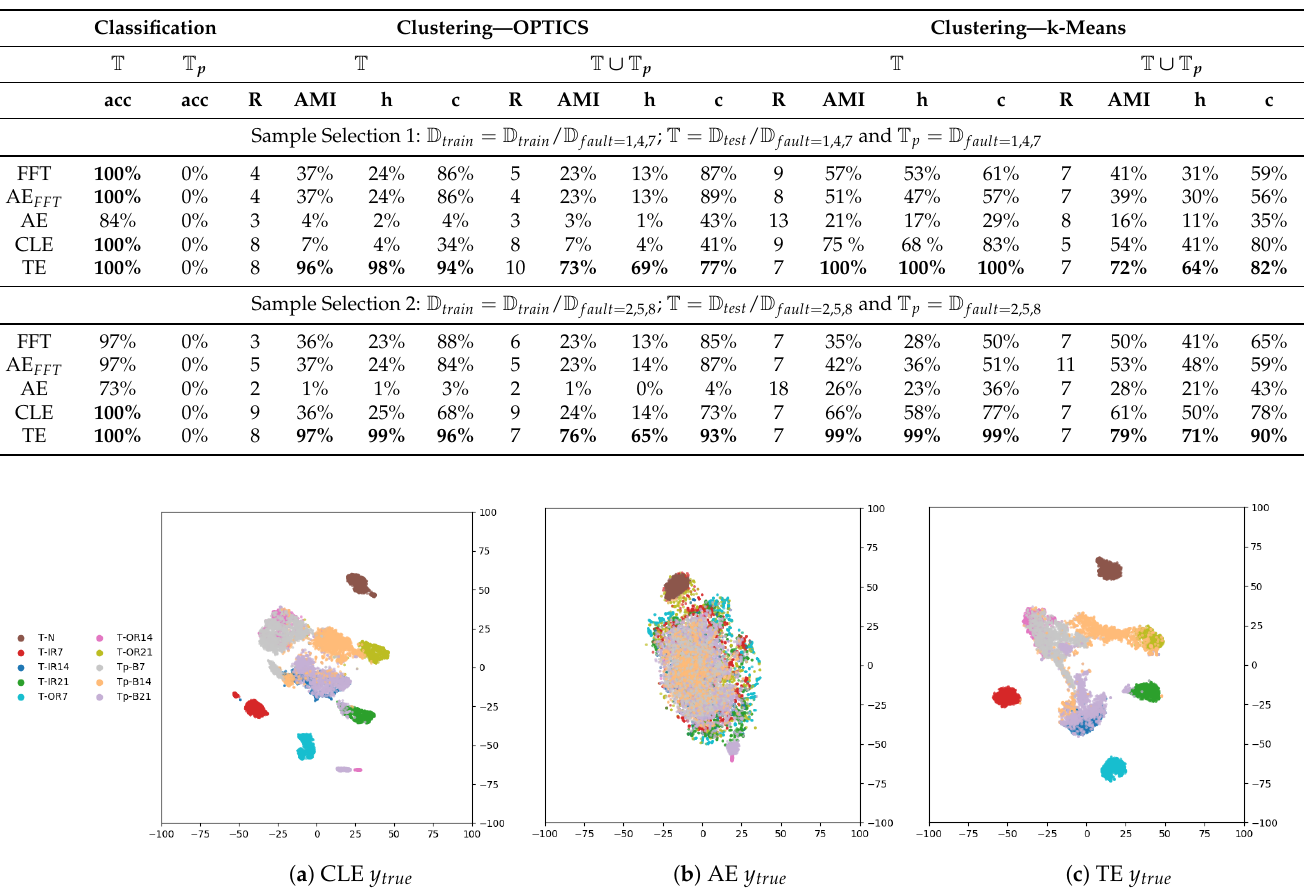
Table 5. Case Study 2: Classification and clustering results with novel faults based on feature spaces of the FFT, the Autoen- coder based on the FFT (AE FFT ), the Autoencoder (AE), the Classifier Encoder (CLE), and Triplet Encoder (TE) Models. (Bold indicates the best